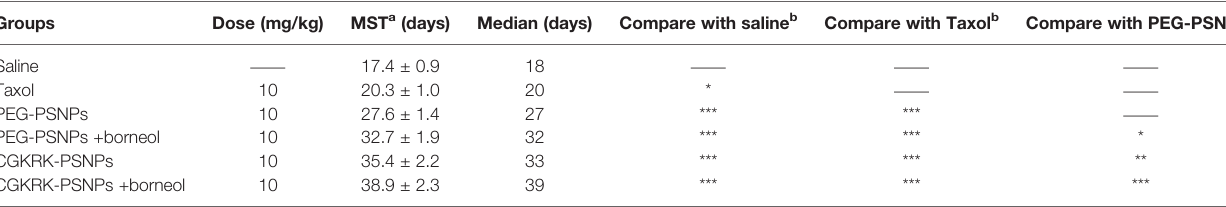
TABLE 2 | In vivo anti-glioma ef fi cacy of different PTX formulations on intracranial U87MG glioma mice model (n = 9). Groups